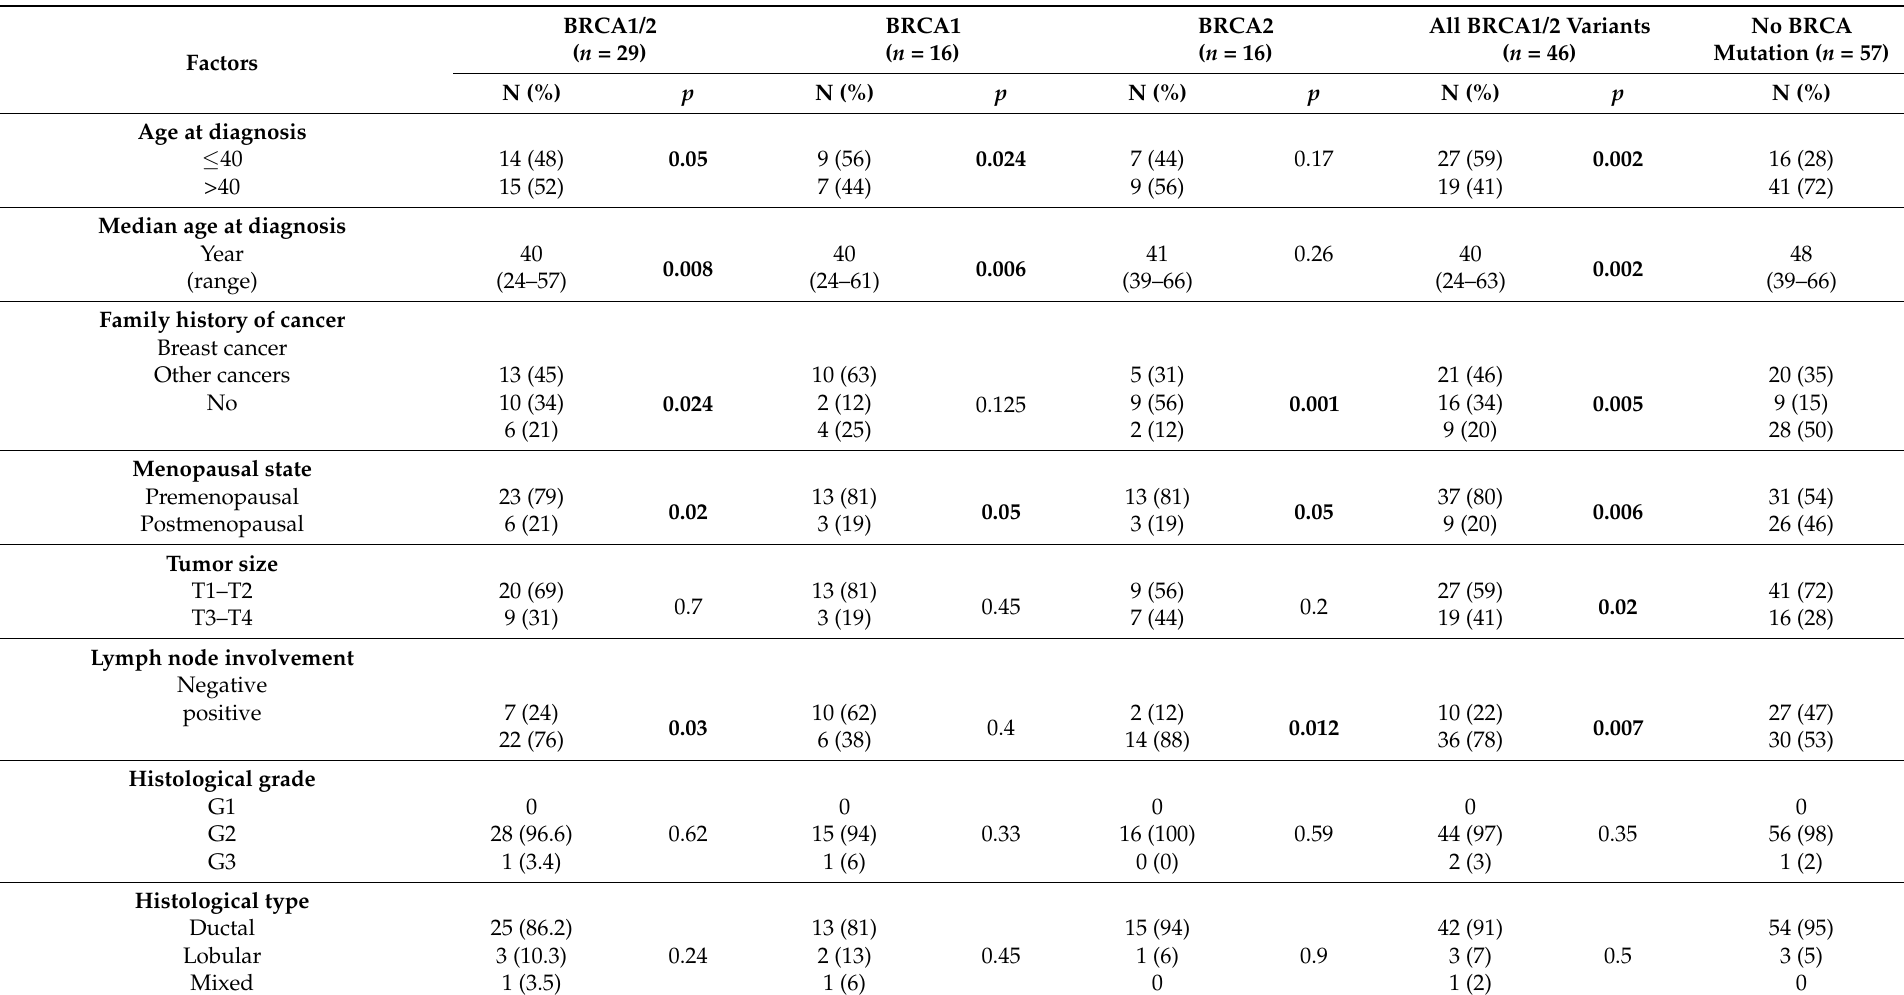
Table 1. Clinicopathological characteristics of BRCA1/BRCA2 mutation carriers (together and separately) and